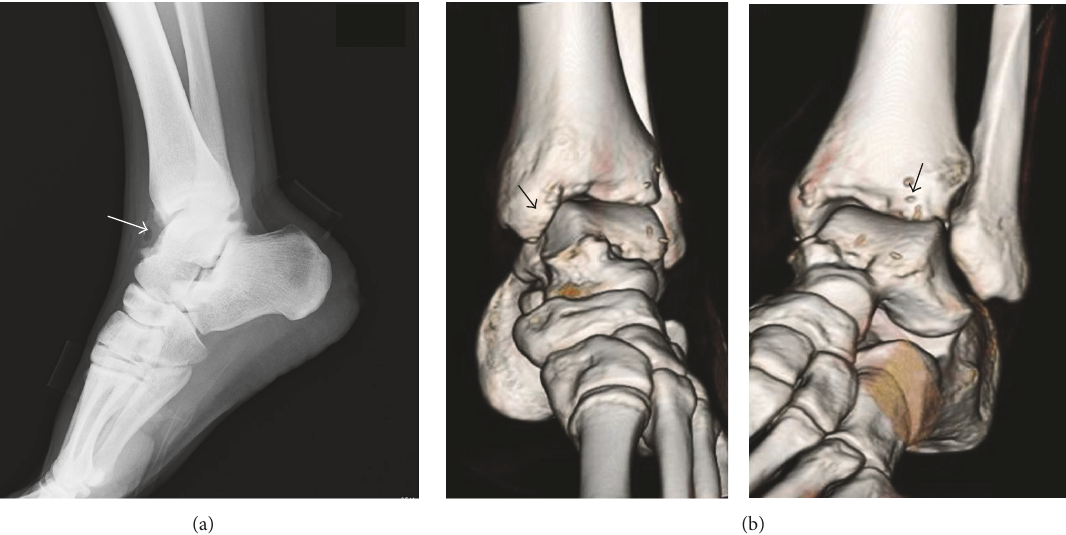
Figure 3: (a) A plain radiograph and (b) a three-dimensional computed tomography scan after ankle arthroscopy showing resection of osteophytes at the anterior edge of the distal tibial end and at the dorsal talar neck ((a) white arrow, (b) black arrow).